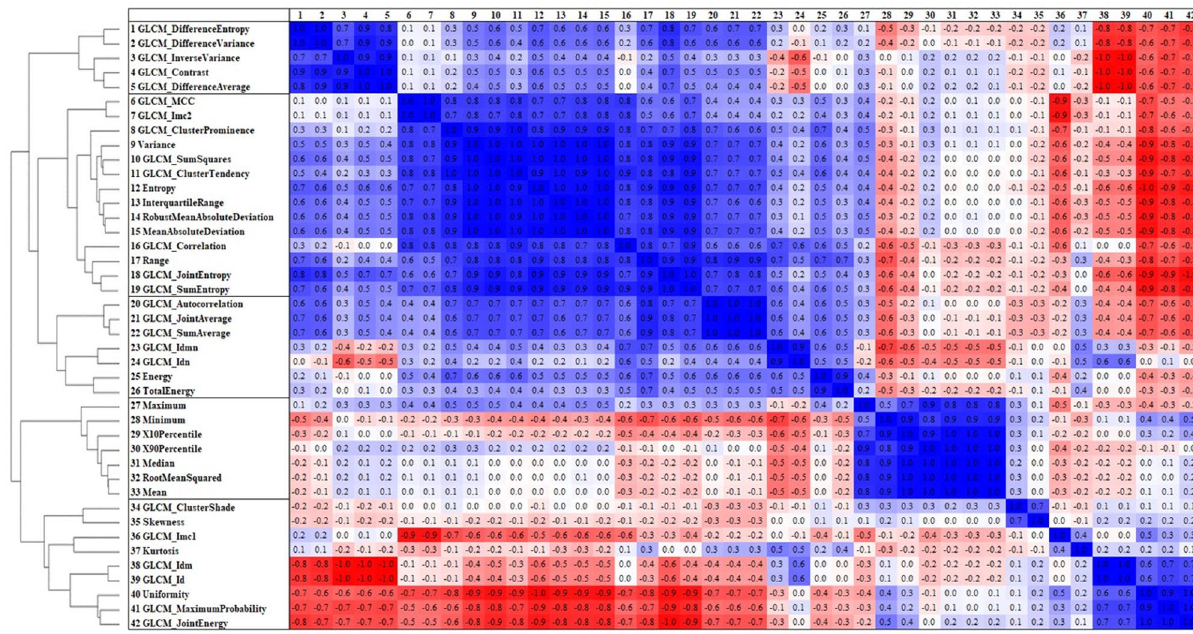
Figure 2. Cluster dendrogram (left) with heatmap (right) for 42 extracted texture features. Normalized Euclidean distance was used in hierarchical cluster analysis. More highly correlated clusters are located nearer to the bottom of the dendrogram. The features were sorted according to the result. Pearson correlation coefficients between respective features are shown in the heatmap; blue and red indicate negative and positive correlations, respectively. The heatmap and cluster dendrogram show a similar tendency.